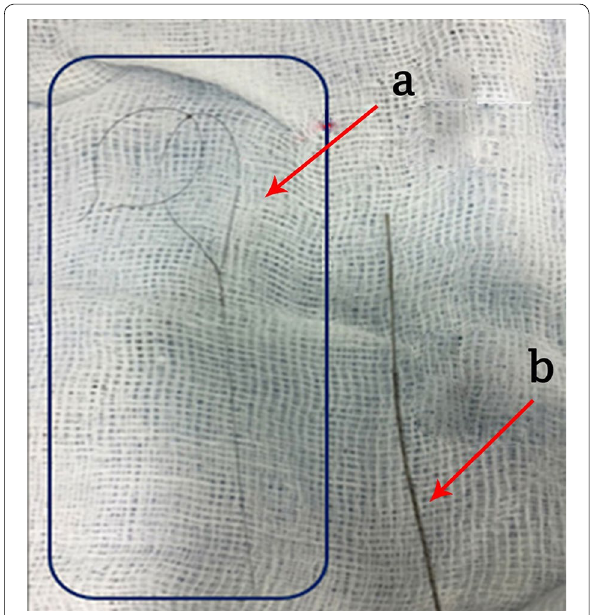
Fig. 2 a The broken basket fragment (wire of distal 4 cm of the tipless nitinol basket) after removal. b The proximal part of basket with intact